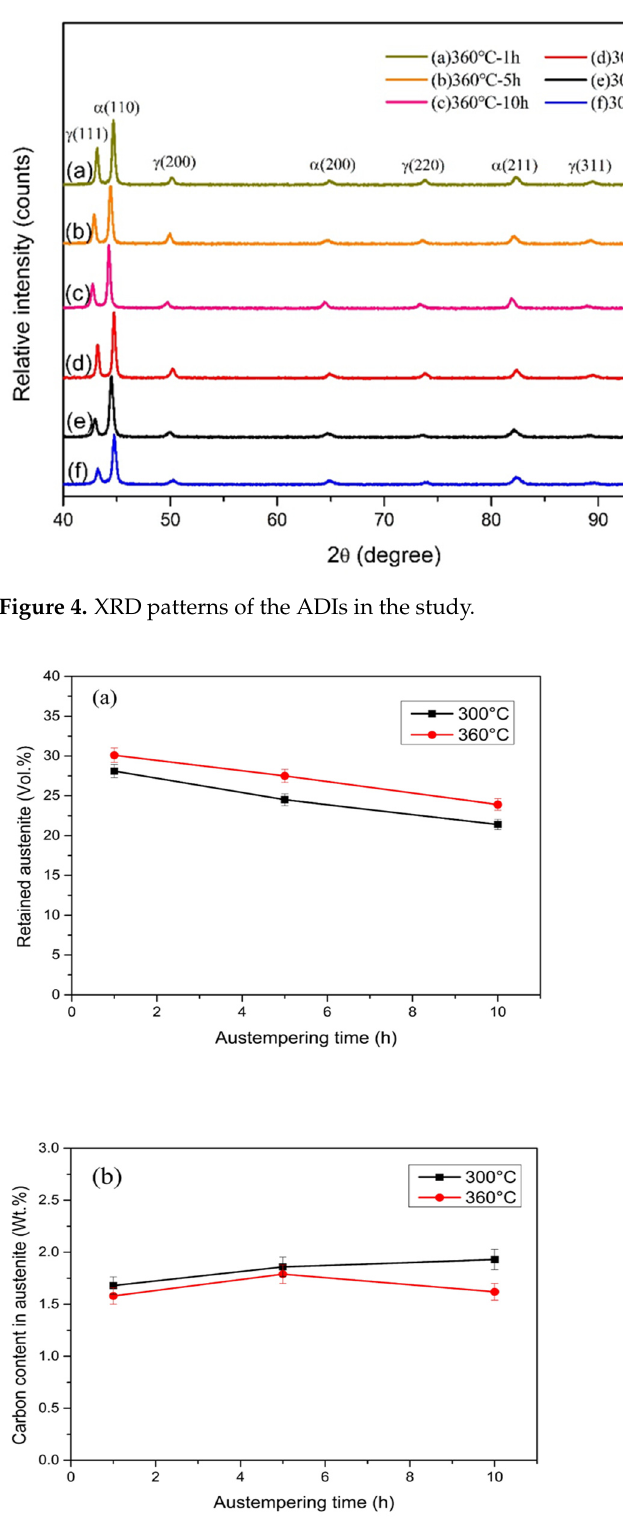
Figure 5. The effect of austempering parameters on ( a ) retained austenite content and ( b ) carbon content in austenite.